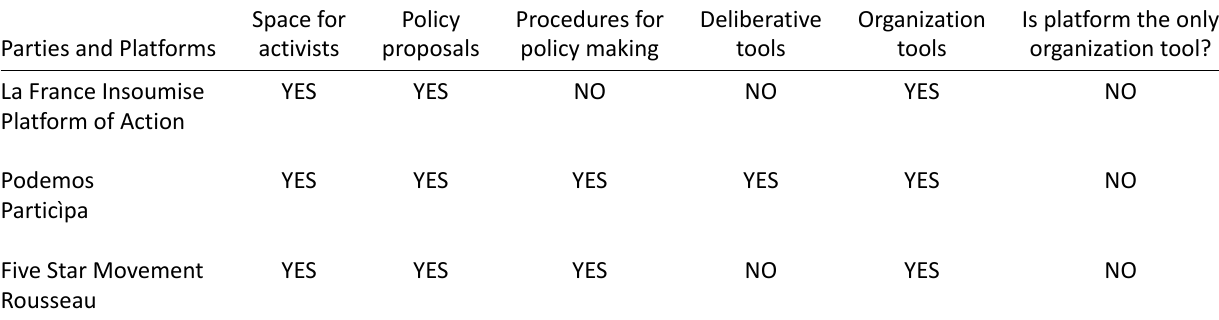
Table 3. Characteristics of the participatory platforms used by La France Insoumise, Podemos, and the Five Star